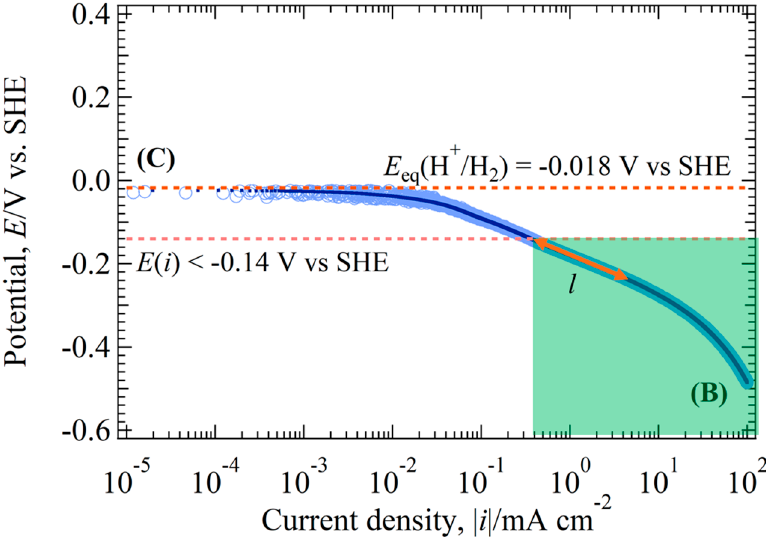
(cid:16) (cid:17) 0.4 mA cm − 2 ≤ | i | . The (B) and (C)